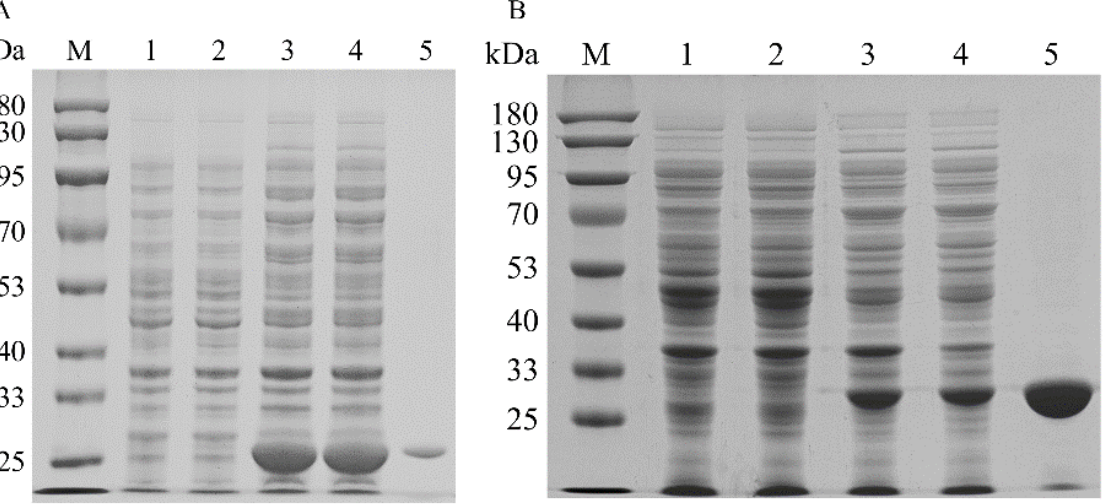
Figure 7. SDS–PAGE analysis of recombinant isopentenyl phosphate kinases in E. coli : ( A ) Figure 7. SDS – PAGE analysis of recombinant isopentenyl phosphate kinases in E. coli : ( A ) SDS – PAGE analysis of MtIPK (lane M: protein marker; lane 1: the total protein of BL21(DE3); lane 2: the soluble protein in BL21(DE3); lane 3: the total protein of BL2-MtIPK; lane 4: the soluble protein in BL21-MtIPK; lane 5: purified MtIPK). ( B ) SDS – PAGE analysis of MthIPK (lane M: protein marker;